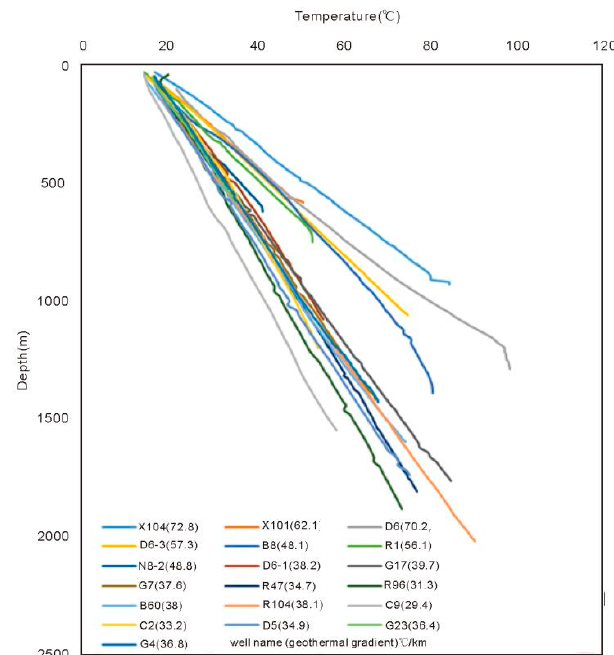
Figure 4. Temperature–depth graph of oilfield wells in the Xiong’an New Area (adapted from Chang Jian [18]).